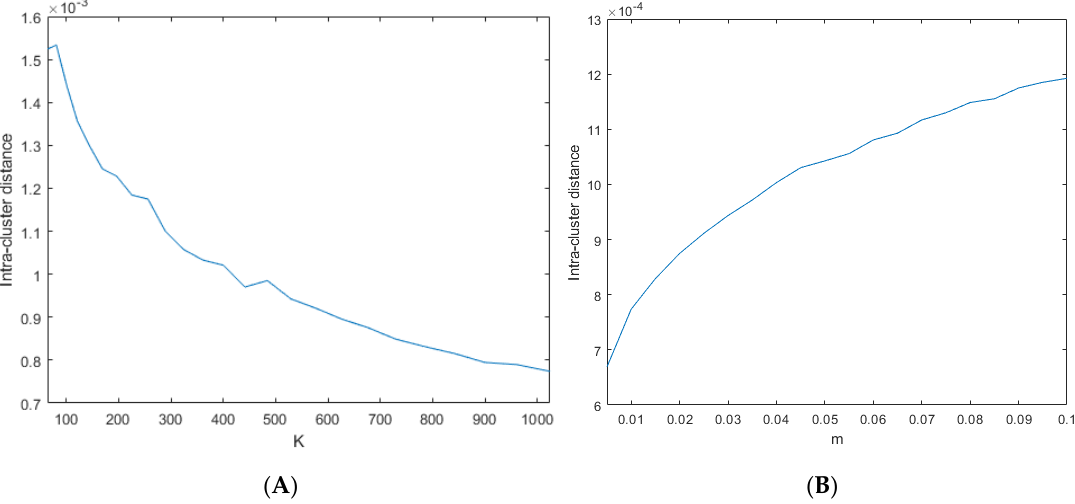
Figure 6. Di ff erent SLIC Intra-cluster distance for di ff erent SLIC hyperparameters: ( A ) K and ( B ) m .